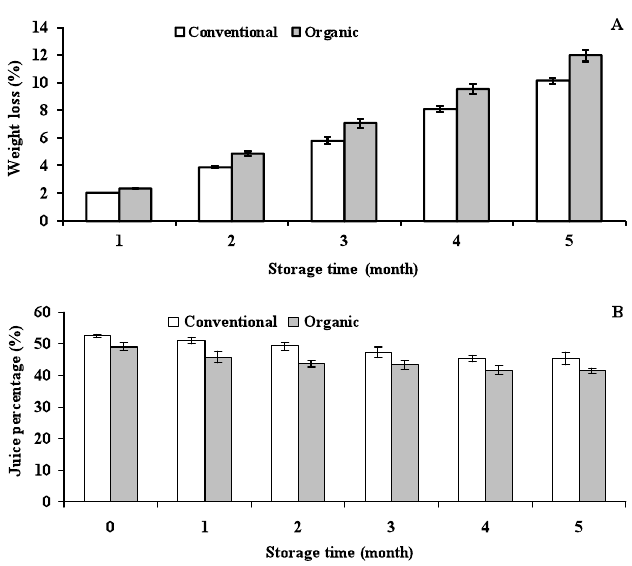
Fig. 1: Changes in weight loss and juice percentage of conventionally and organically grown ‘Washington Navel’ oranges during storage at 4°C.